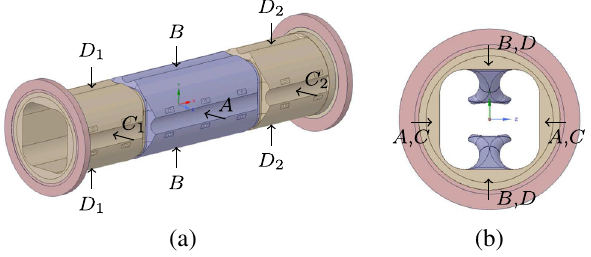
FIG. 21. Considered tuner positions in (a) isometric view and (b) longitudinal view.